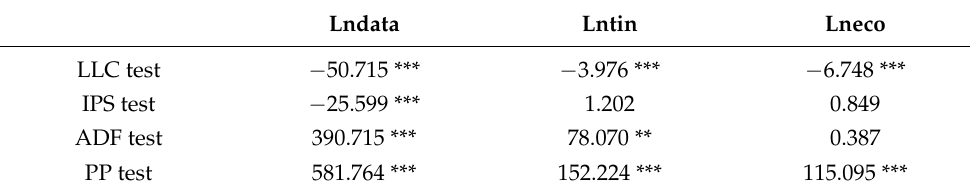
Table 4. Unit root test results.